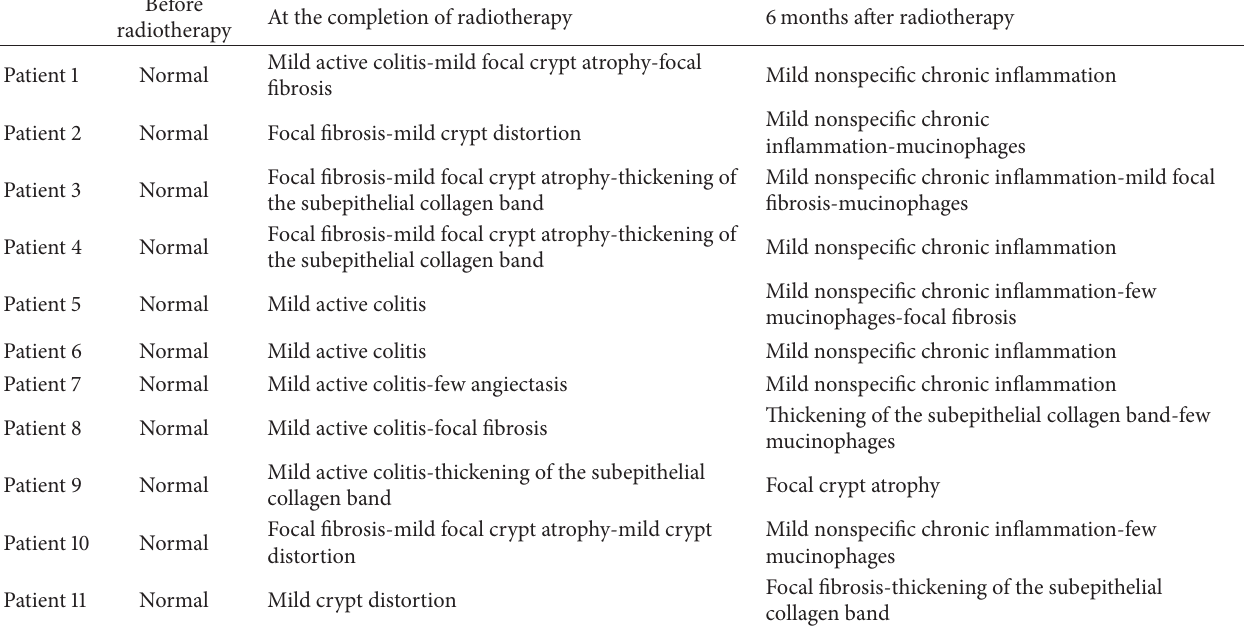
Table 1: Histological findings in an individual patient at three time settings—before, at the completion of, and 6 months after radiotherapy. Before